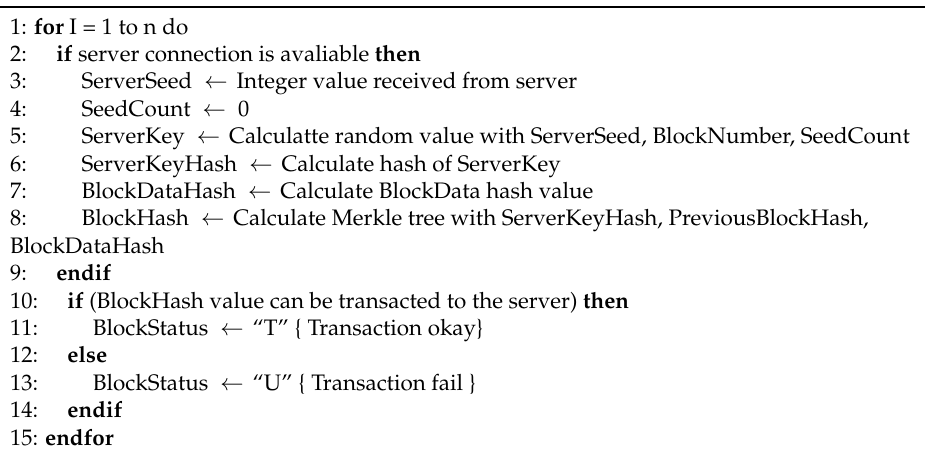
Table 2. Pseudo Code for On-Line Process: Digital Tachograph.